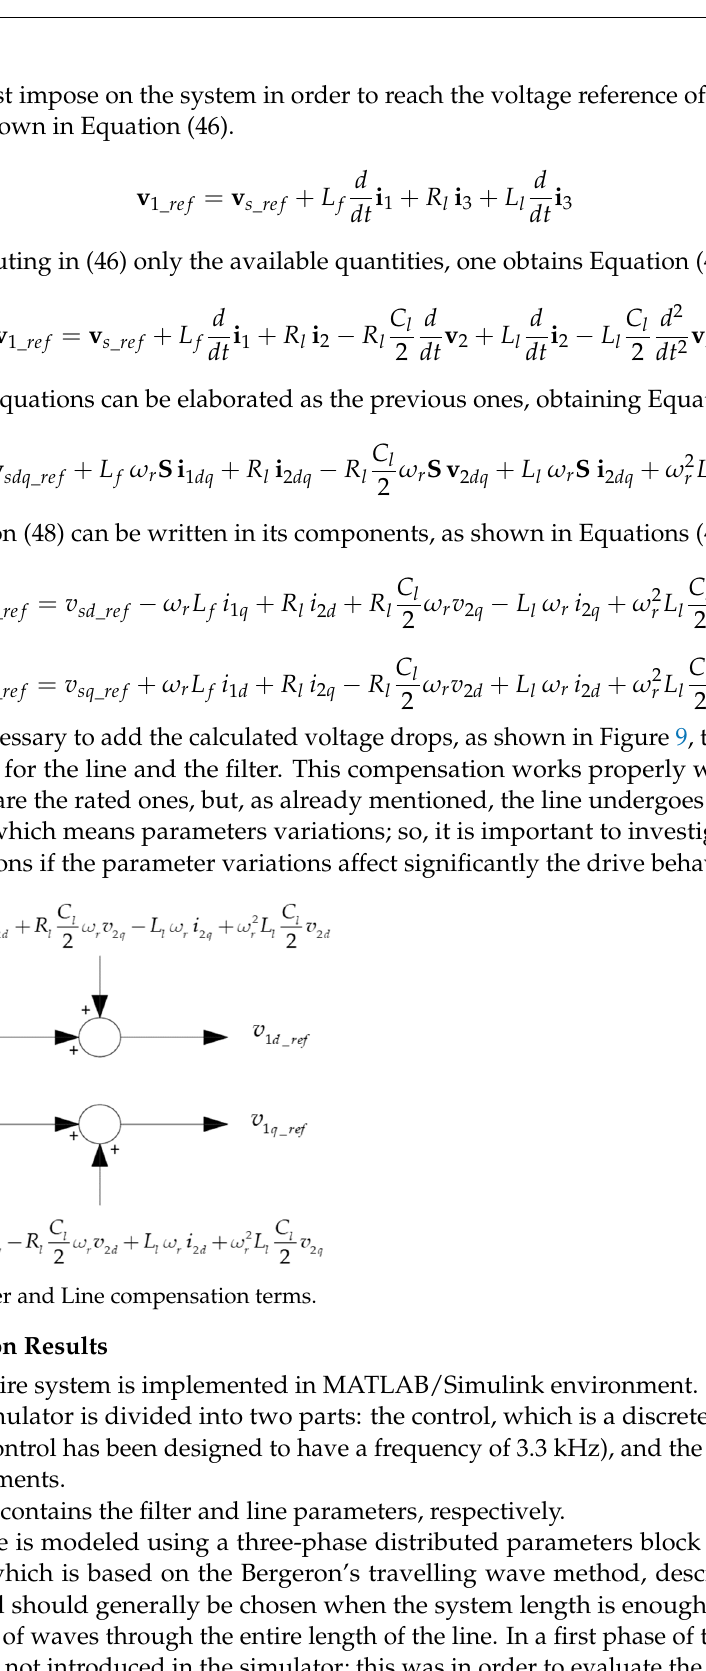
Table 2. Filter and Line parameters.